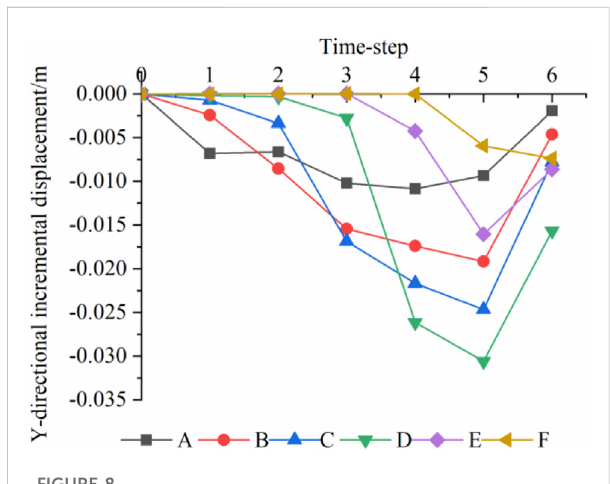
FIGURE 8 Y-directional incremental displacements of monitor points during the F area fi lling process.